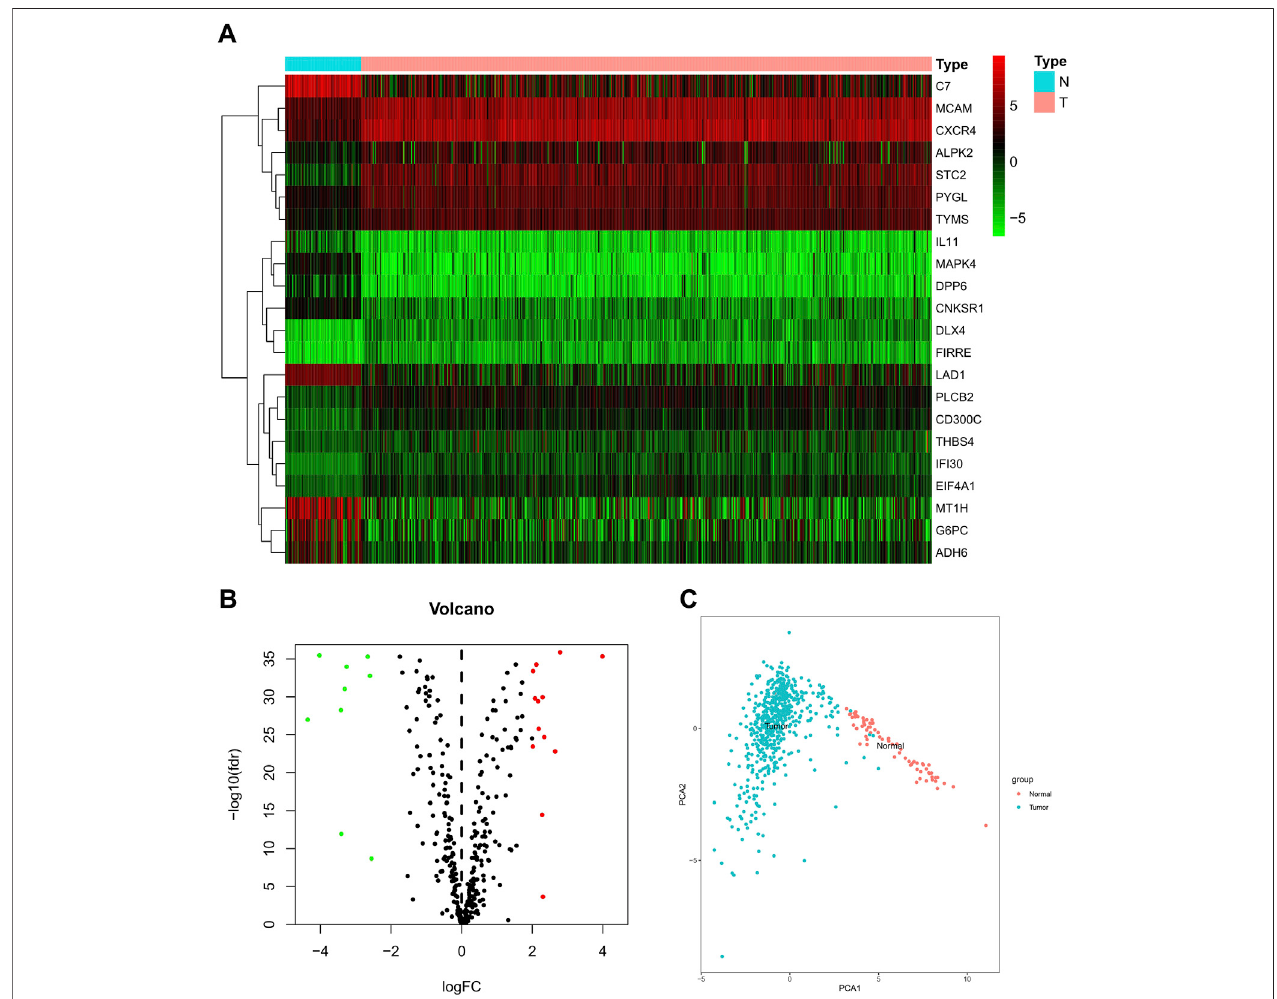
FIGURE 1 | Different expressions of butyrate-metabolism-related genes in ccRCC and normal renal tissues. (A) Heatmap for 22 butyrate-metabolism-related genes from TCGA-KIRC cohort. (B) Volcano plot for screened butyrate-metabolism-related genes. (C) Principal component analysis for the expression of butyrate- metabolism-related genes to distinguish tumors ( n = 539) from normal samples ( n = 79) in TCGA cohort.